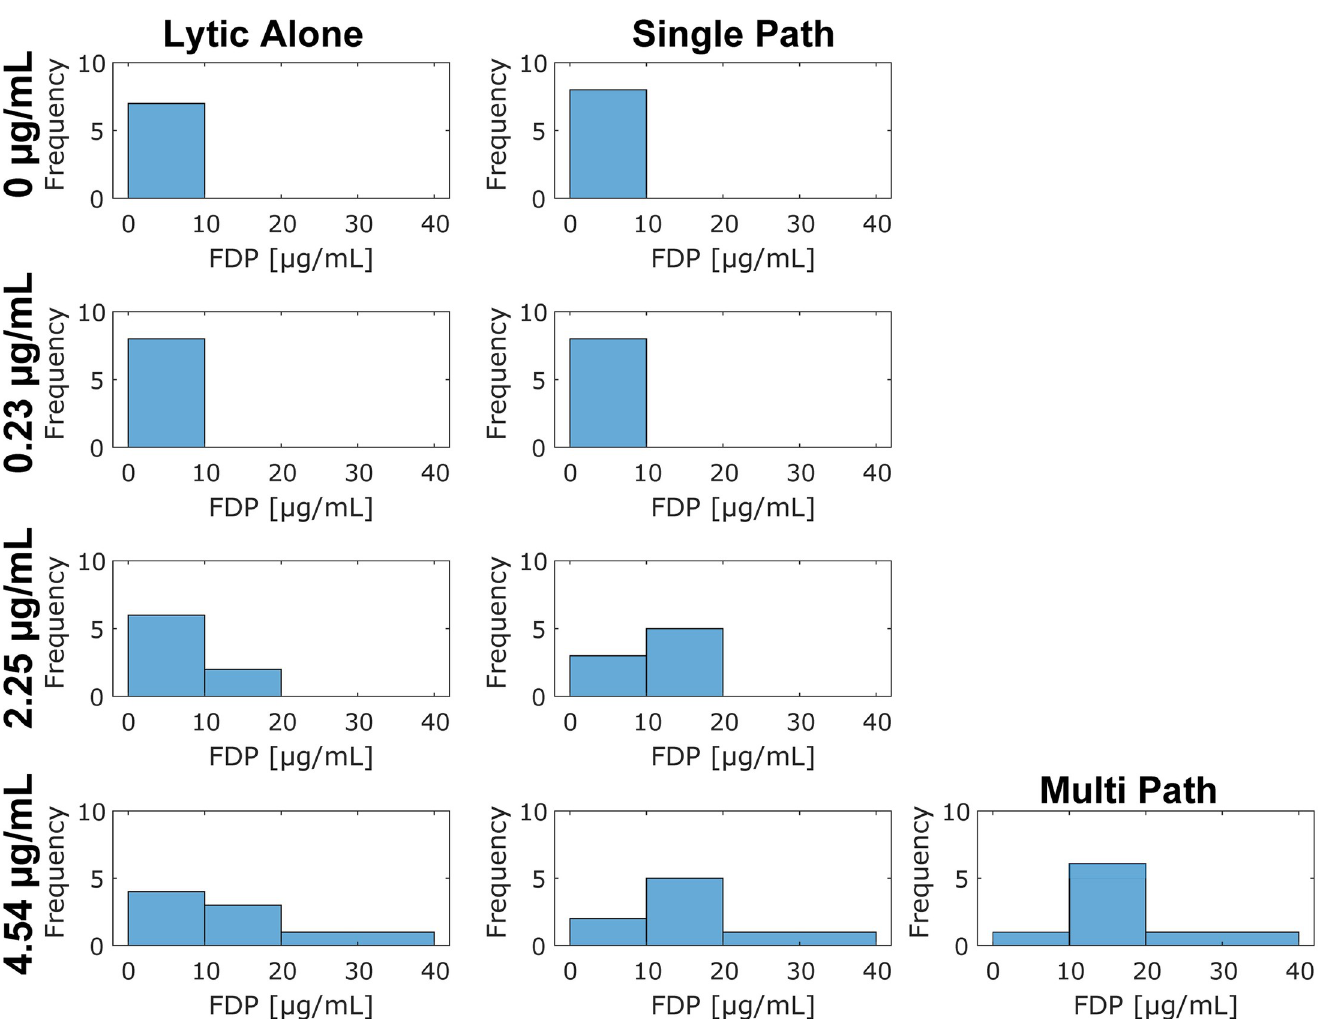
Fig 6. Observed concentration of non-specific fibrin degradation products (FDPs) generated for each treatment arm. The concentration of rt-PA is noted along the left. The left column of subfigures corresponds to rt-PA-only arms, and the right column of subfigures corresponds to histotripsy and lytic. The multi-path histotripsy exposure scheme is labeled in the third column. The assay is semi-quantitative, so concentrations are reported in bins from 0 to 10 μ g/mL, 10 to 20 μ g/mL, and 20 to 40 μ g/mL. The number of datasets observed within each bin are reported for each arm, as indicated by the ‘Frequency’ on the subplot ordinate.